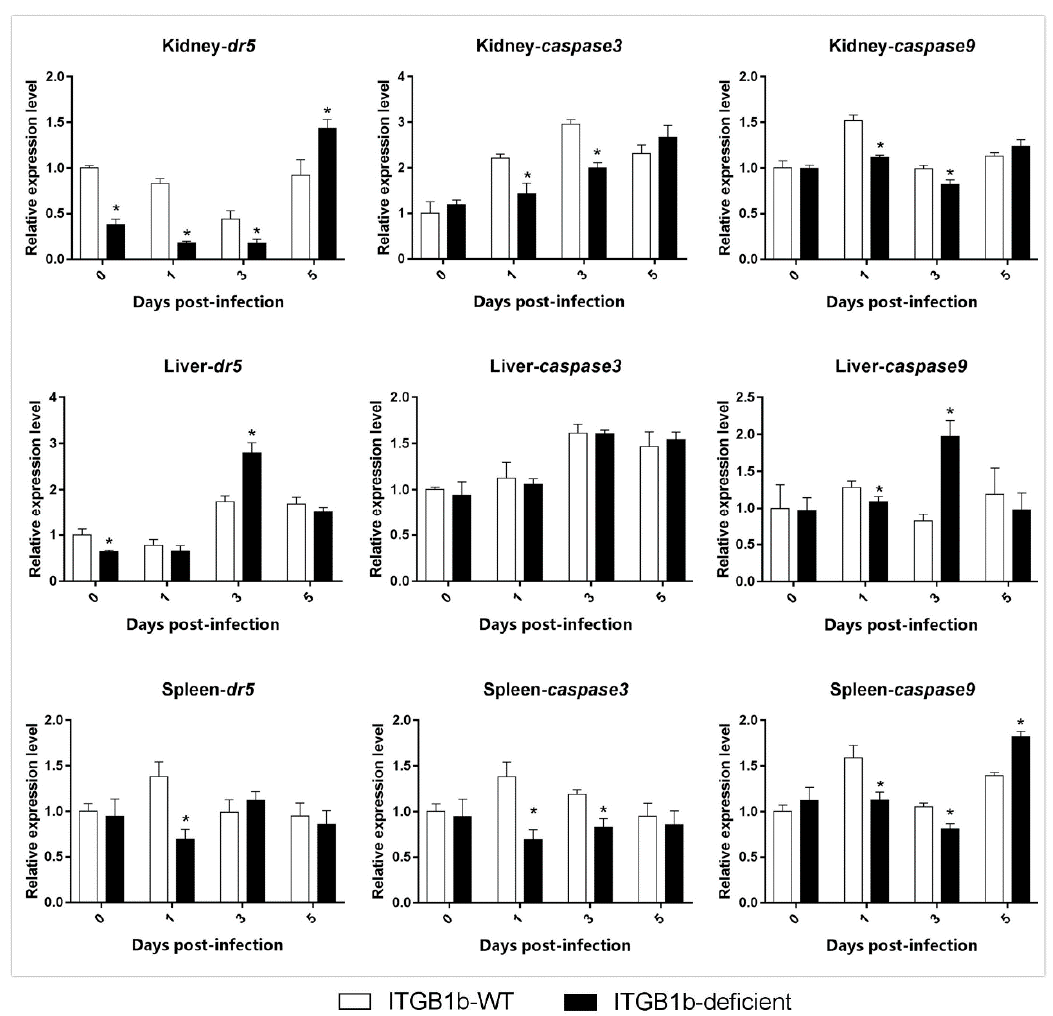
Figure 7. Expression of apoptosis-related genes in ITGB1b-deficient and wild-type rare minnows. The relative expression levels were calculated as the ratio of gene expression level in ITGB1b-deficient fish relative to that in wild-type fish at 0 dpi. A significant difference ( p < 0.05, ANOVA) in gene expression level between the wild-type and ITGB1b-deficient and wild-type rare minnows is indicated with an asterisk (*).